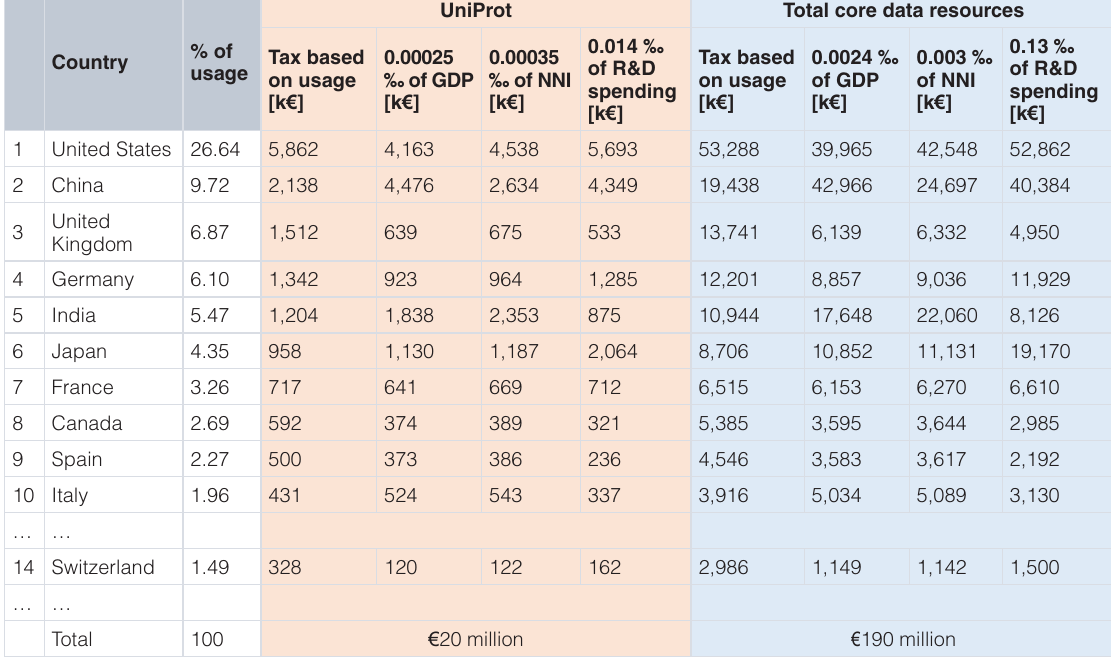
Table 2. Model 1, National funding. Potential amounts from the top-10 UniProt user countries to sustain UniProt (orange columns) and the total core data resources (blue columns). Costs per country as a function of (1) usage, (2) Gross